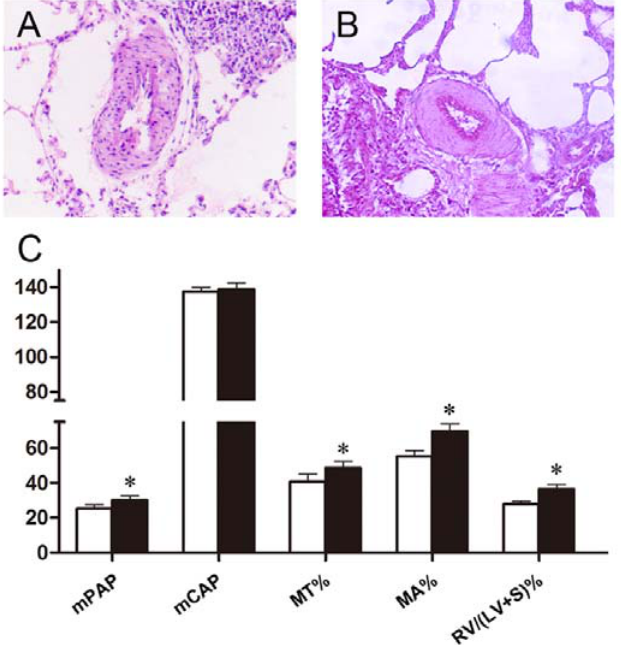
Figure 5. Effects of THX preconditioning on pulmonary hypertension and vascular remodeling in polydatin-treated rats. ( A ) Representative image of HE staining; ( B ) representative image of van Gieson counterstaining; ( C ) White column: 20 mg/kg polydatin group; Black column: THX preconditioning group. n = 8. * p < 0.05 vs. polydatin